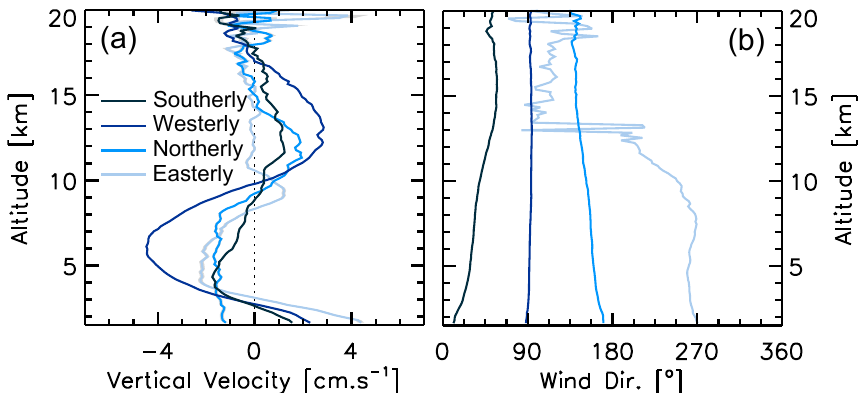
Figure 5. (a) Mean vertical velocities for different 2km wind directions. 30 months of data from May 2011 have been used. The four curves comprise measurements whose 2km wind vectors are within 45 ◦ of north, south, east and west (indicated in the legend as southerlies, northerlies, westerlies, and easterlies, respectively). Shading gives the standard error, which is often smaller than the line thickness. (b) Mean wind direction in the profile when the direction at 2km lies in one of the four quadrants.